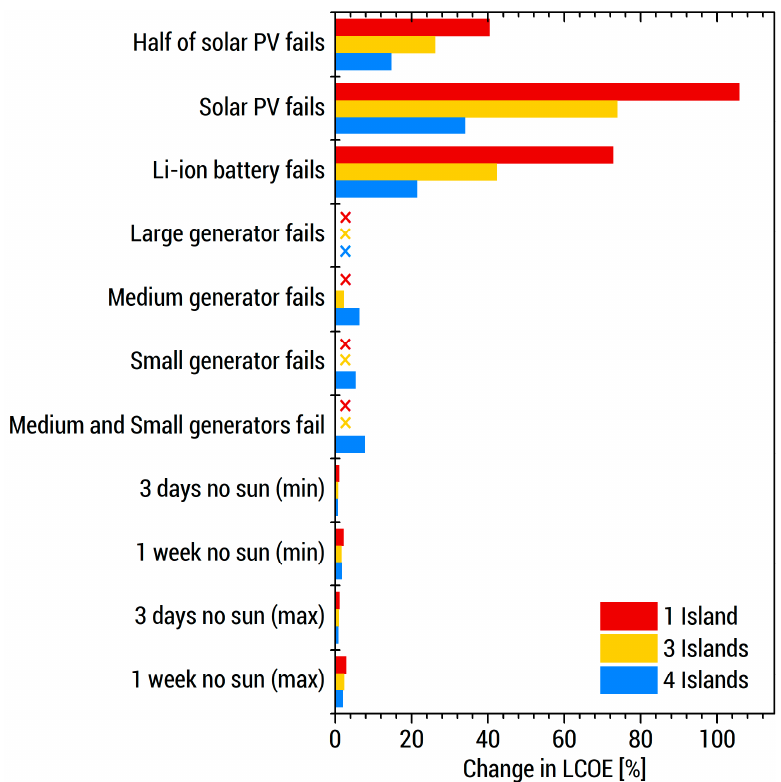
Figure 8. Change in LCOE when a disturbance is applied to Jomalig decentralized HRES (1 island), the Po–Pa–Pt clustered HRES (3 islands), and the Po–Pa–Pt–Jo clustered HRES (4 islands). An × mark indicates a technically infeasible system.